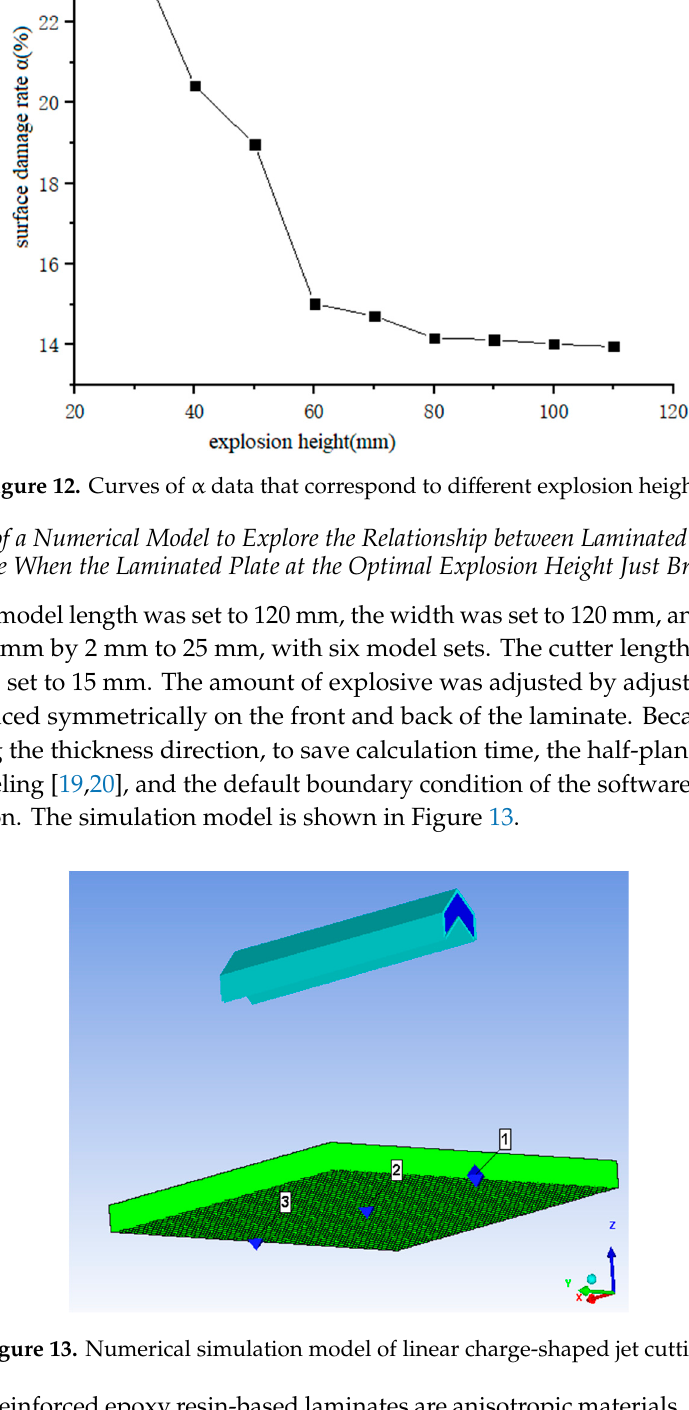
. Table 4. Stress values and F values of monitoring points. Stress